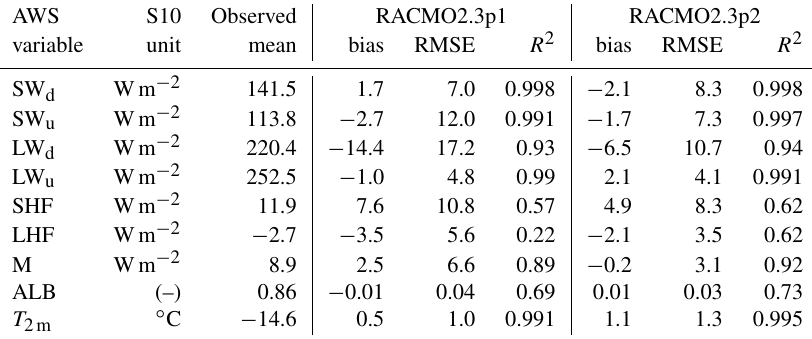
Table 5. Modelled and observed mean SEB components and statistics of the differences (2010–2015) at station S10 in the accumulation zone (1850ma.s.l.). Statistics include means of measurements collected at S10, model bias (RACMO2.3pX – observations), RMSE of the bias as well as the determination coefficient of monthly mean data. All fluxes are set to